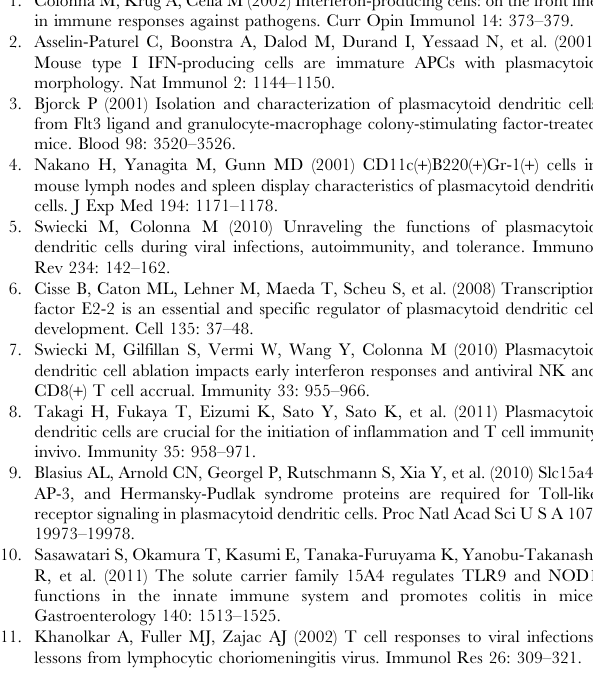
cell responses against an acute LCMV Armstrong